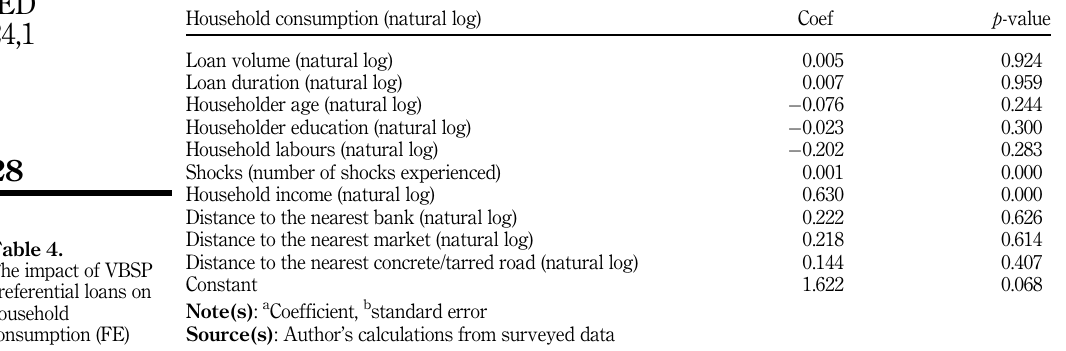
Table 4. The impact of VBSP preferential loans on household consumption